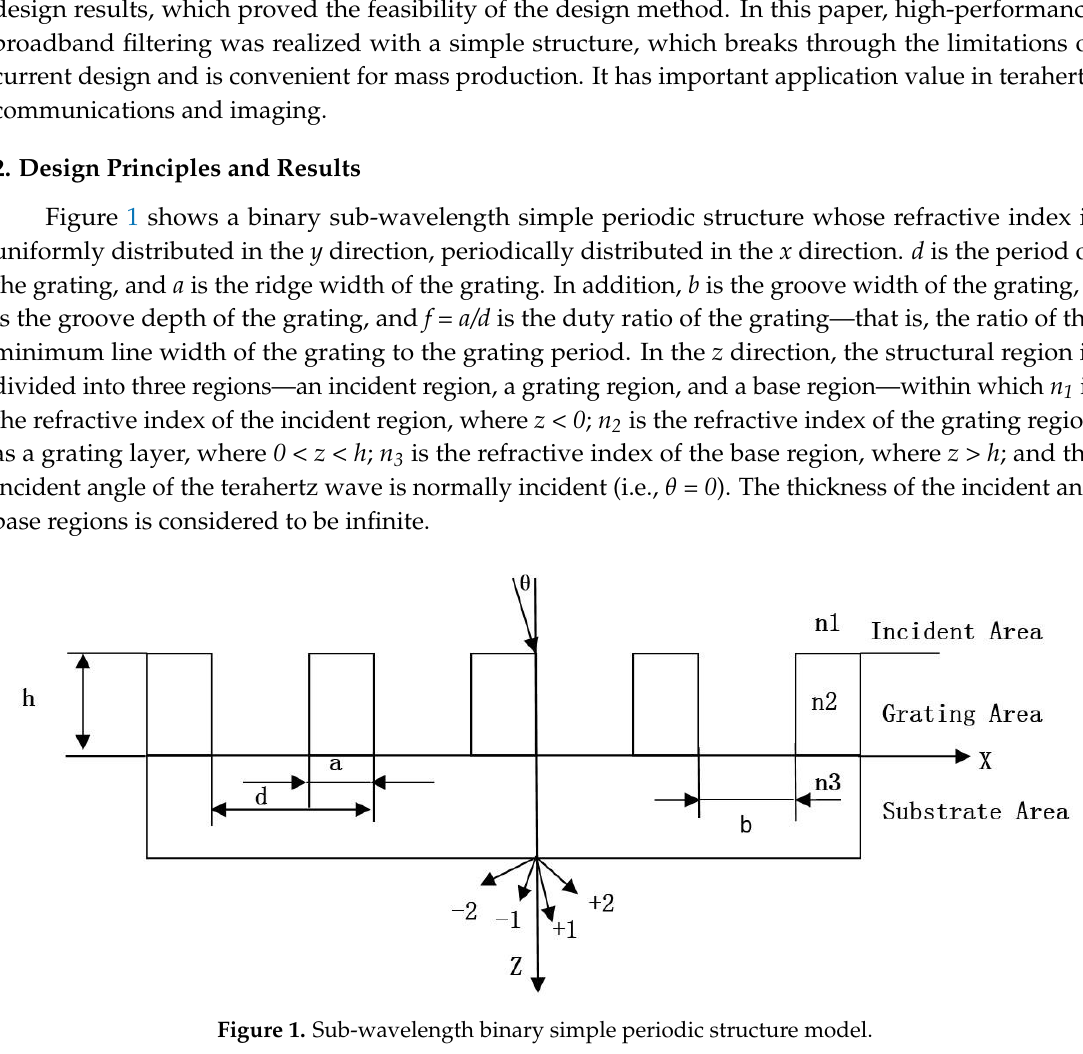
Figure 1. Sub-wavelength binary simple periodic structure model.